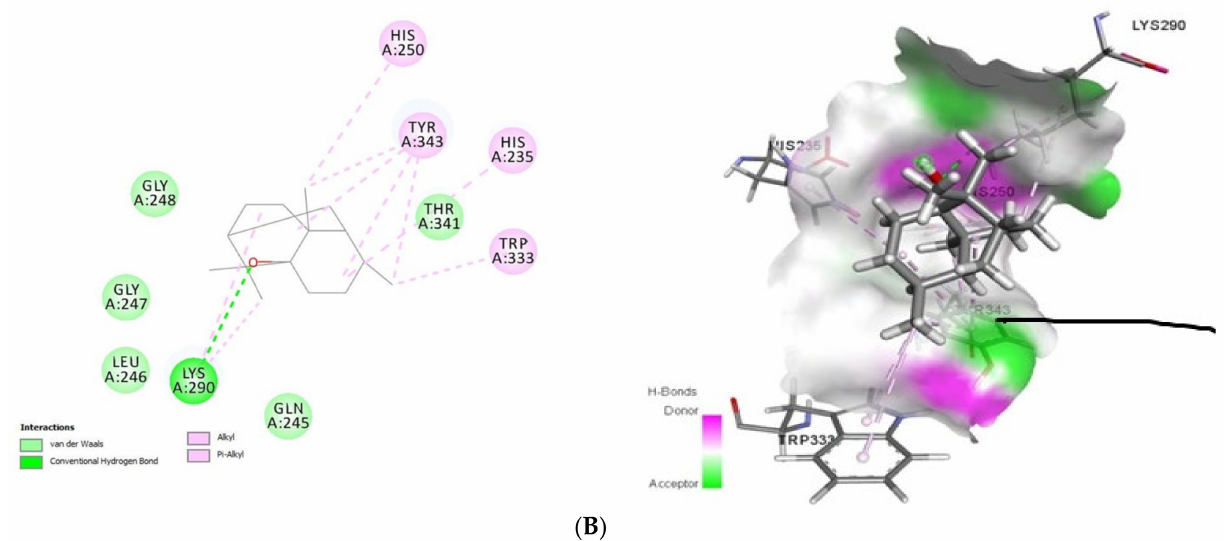
Figure 3. 2D (left) and 3D (right) of tomatidine ( A ) and patchouli alcohol ( B ) with the active site of 6VWW. ( A ): Tomatidine- NSP15 (PDB ID: 6VWW) (Gold Fitness Score 43.62); Type of binding: van der Waals: Pro344, Lys345, Leu346, Ser294, Val292, Cys293, Gly247, Lys290, Gly248, Thr341, Lys345, Trp333, Glu340; C-H bond: His235; Pi-Sigma: Tyr343; Pi-Alkyl: His250, Tyr343, His235. ( B ): Patchouli alcohol-NSP15 (PDB ID: 6VWW) (Gold Fitness Score 27.47); Type of binding: van der Waals: Gly248, Glu247, Leu246, Gln245, Thr341; H-bond: Lys290; Alkyl/Pi-Alkyl: His250, Tyr343, His235,